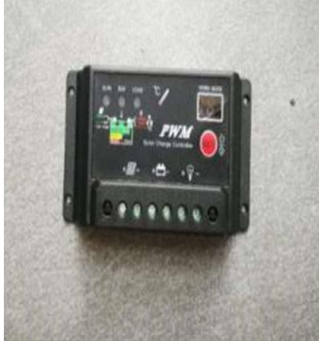
Figure 6. Accumulator.